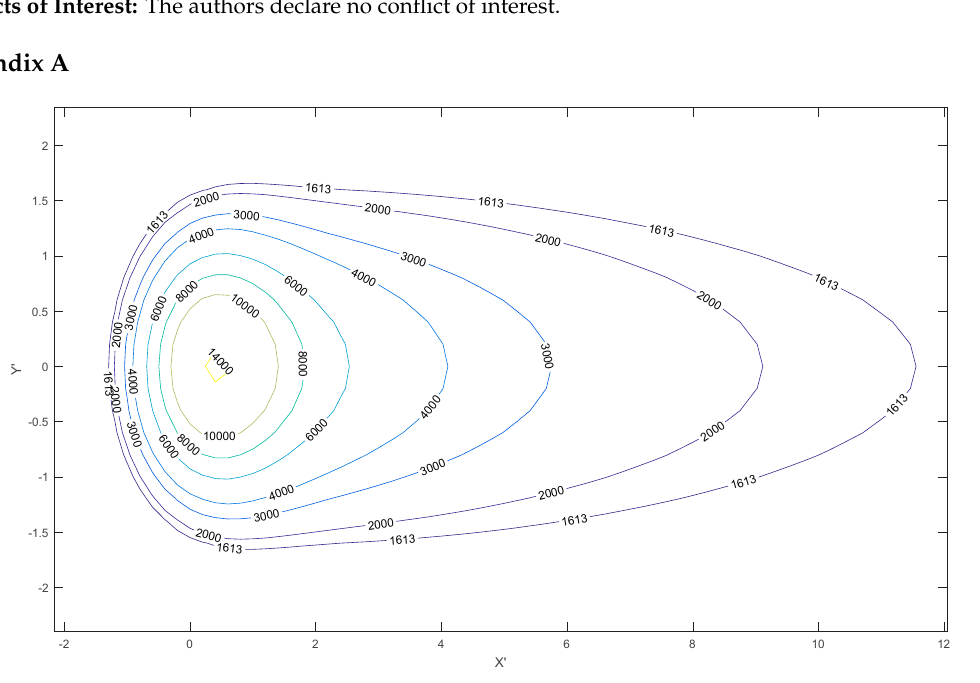
Figure A1. Melt pool temperature contour at top view for In718 with a laser power of 100 W, scanning speed of 1 mm/s, laser spot radius of 50 μ m and A = 0.5.